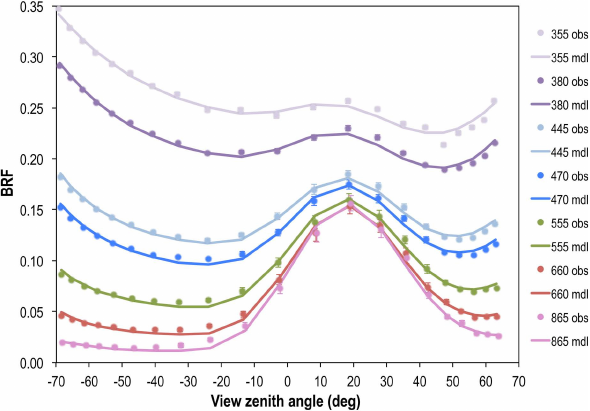
Fig. 11. Measured DOLP in the three polarimetric AirMSPI bands (circles) as a function of view zenith angle compared to results for the monomodal model with 0.06µm median particle radius (solid lines). Error bars represent the standard deviation in observed DOLP within the 100m × 100m target area.